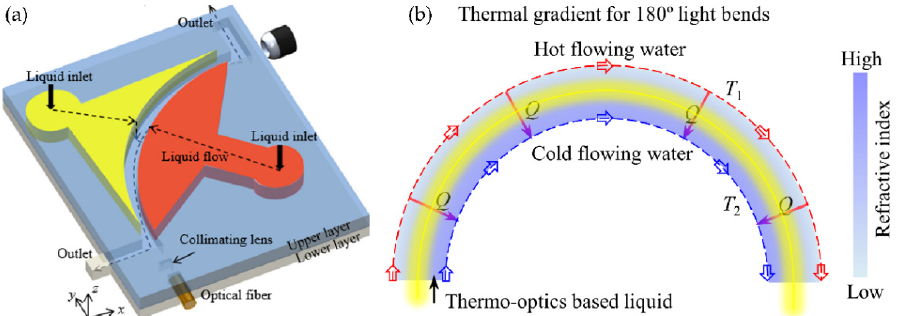
Figure 32. Diffusion device: ( a ) Counterflow convection–diffusion, Refractive index profile in a concentration gradient light-bending device [43]. ( b ) thermal-gradient bending device, conceptual design of the concentration gradient bending device and refractive index profile in a thermal gradient light-bending device [44]. Reprinted with permission from Refs. [43,44]. 2017 and 2020 The Optical Society.